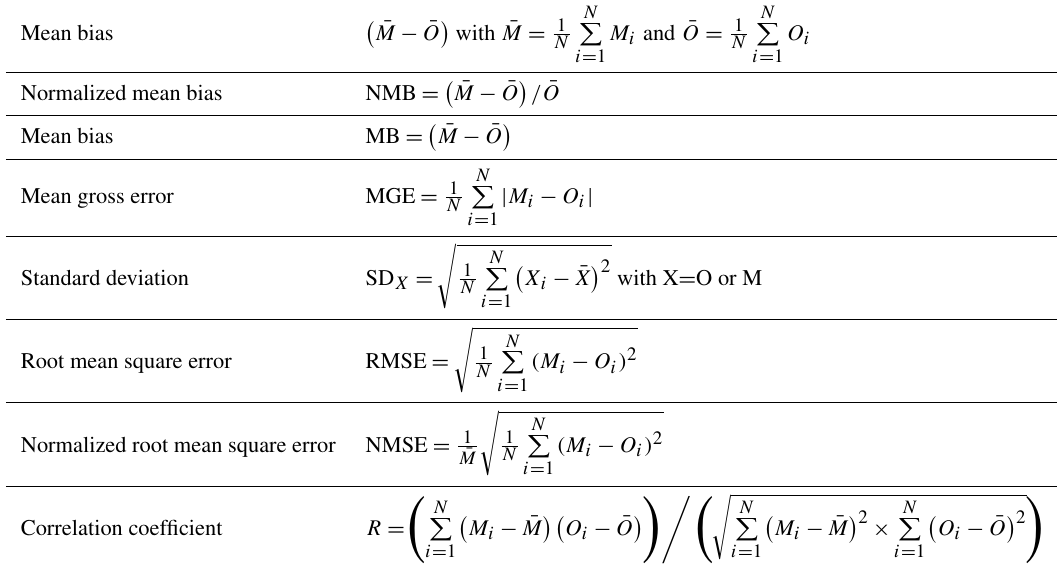
Table 4. Error statistics used to evaluate model performance ( M and O refer, respectively, to model and observation data, and N is the number of